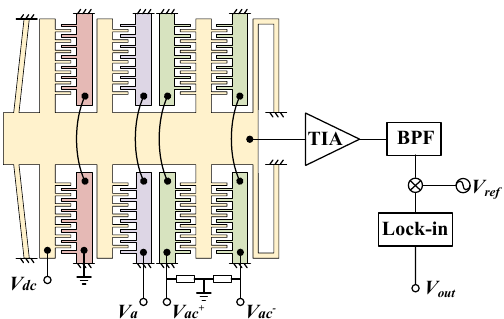
Figure 8. Schematic of the CVC readout circuit.